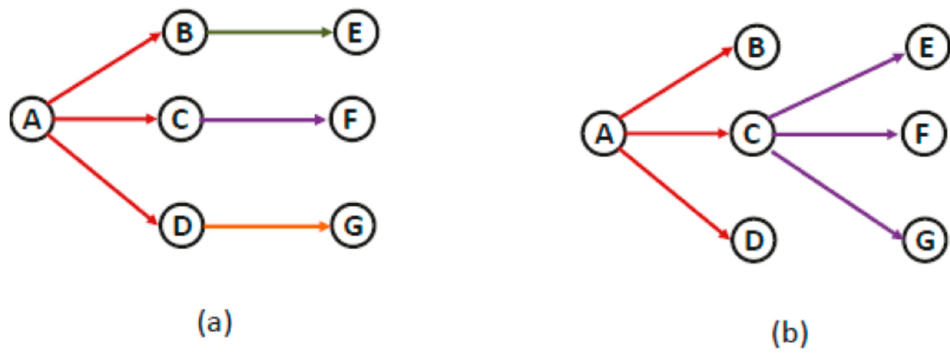
Figure 2. ( a ) A, B, C, and D are the forwarding nodes; ( b ) A and C are the forwarding nodes.